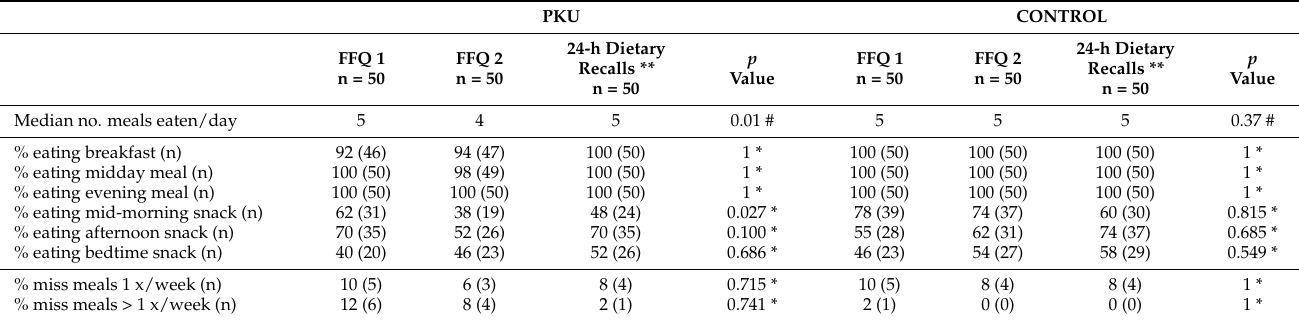
Table 1. Meal patterns—percentage of subjects consuming meals and snacks, or missing meals for FFQ 1, FFQ 2 and dietary recalls (PKU and control groups).